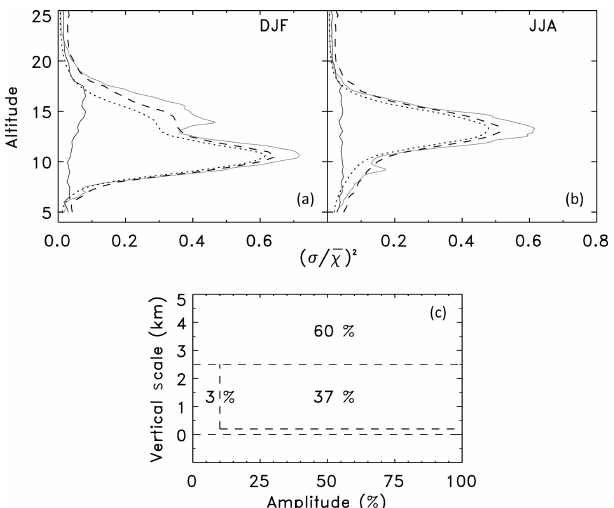
Figure 8. Normalized seasonal variances in ozone for DJF (a) and JJA (b) . Plotted are the normalized total variance (solid gray), basic state variance (dotted), laminae variance (solid black), and the sum of basic state and laminae variances (dashed). Panel (c) shows the annual mean contributions to the total variance between 5 and 25km altitude, as a function of amplitude and the vertical scale of features in the ozonesonde profile.